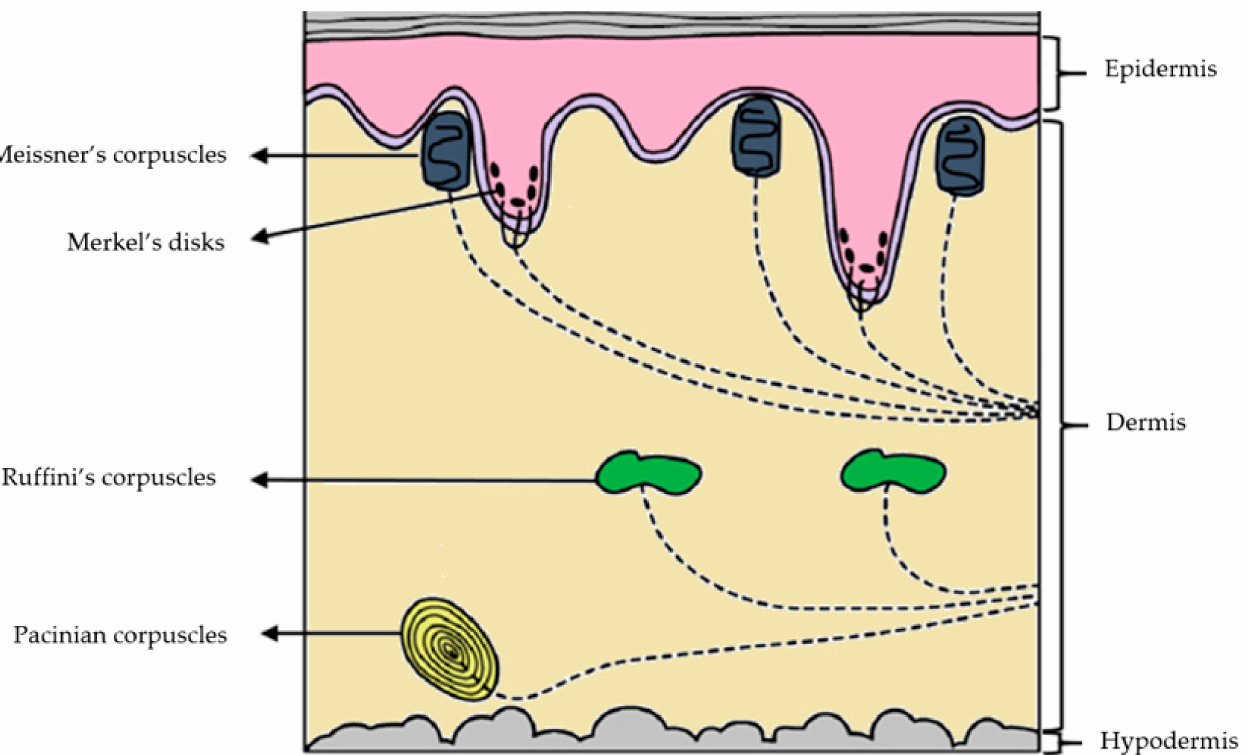
Figure 2. The major types of mechanoreceptors engrained in the hairless skin of the fingertip based on the work of Purves et al. [25]. The tactile properties of each mechanoreceptor are summarized in Table 1. Table 1. The properties of the different types of mechanoreceptors engrained in the skin based on the work of Purves et al. [25]. Meissner’s Corpuscles Ruffini’s Corpuscles Pacinian Corpuscles Merkel’s Discs Touch and moving Vibration and deep Perceived stimuli Stretching of the skin Touch and static stimuli pressure